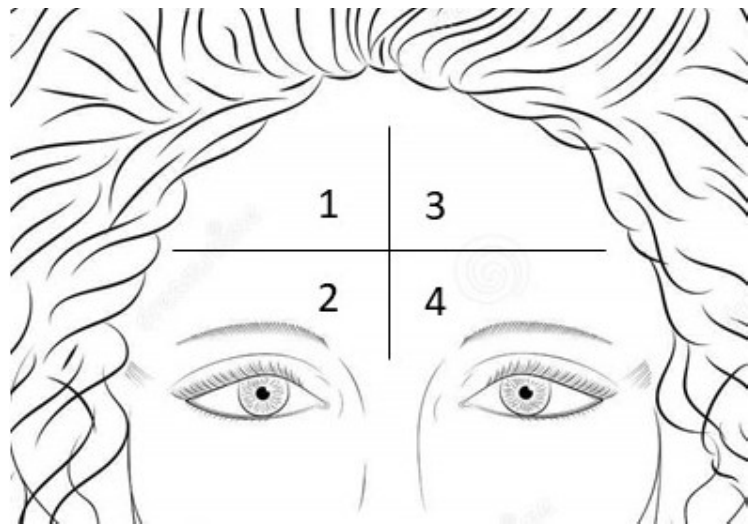
Figure 11. Forehead division for measurements of sebometry. Each product was applied in one of the four areas of the forehead.